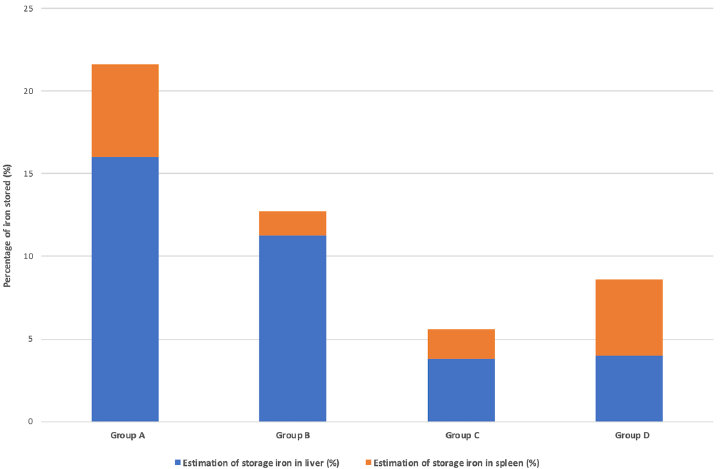
Figure 4. Percentage of infused iron stored in the liver and spleen in 40 dialysis patients. Percent- age of infused iron stored in the liver and spleen estimated by the Brissot regression slope [32] in: Group A: 11 patients treated with 1.2 g iron sucrose; Group B: 14 patients treated with 2.4 g iron sucrose; Group C: 15 patients treated with ferric carboxymaltose; Group D: 14 patients treated with iron isomaltoside. Estimation of LIC + SIC, p = 0.0012 (Chi 2 test); estimation of LIC, p = 0.0015 (Chi 2 test).